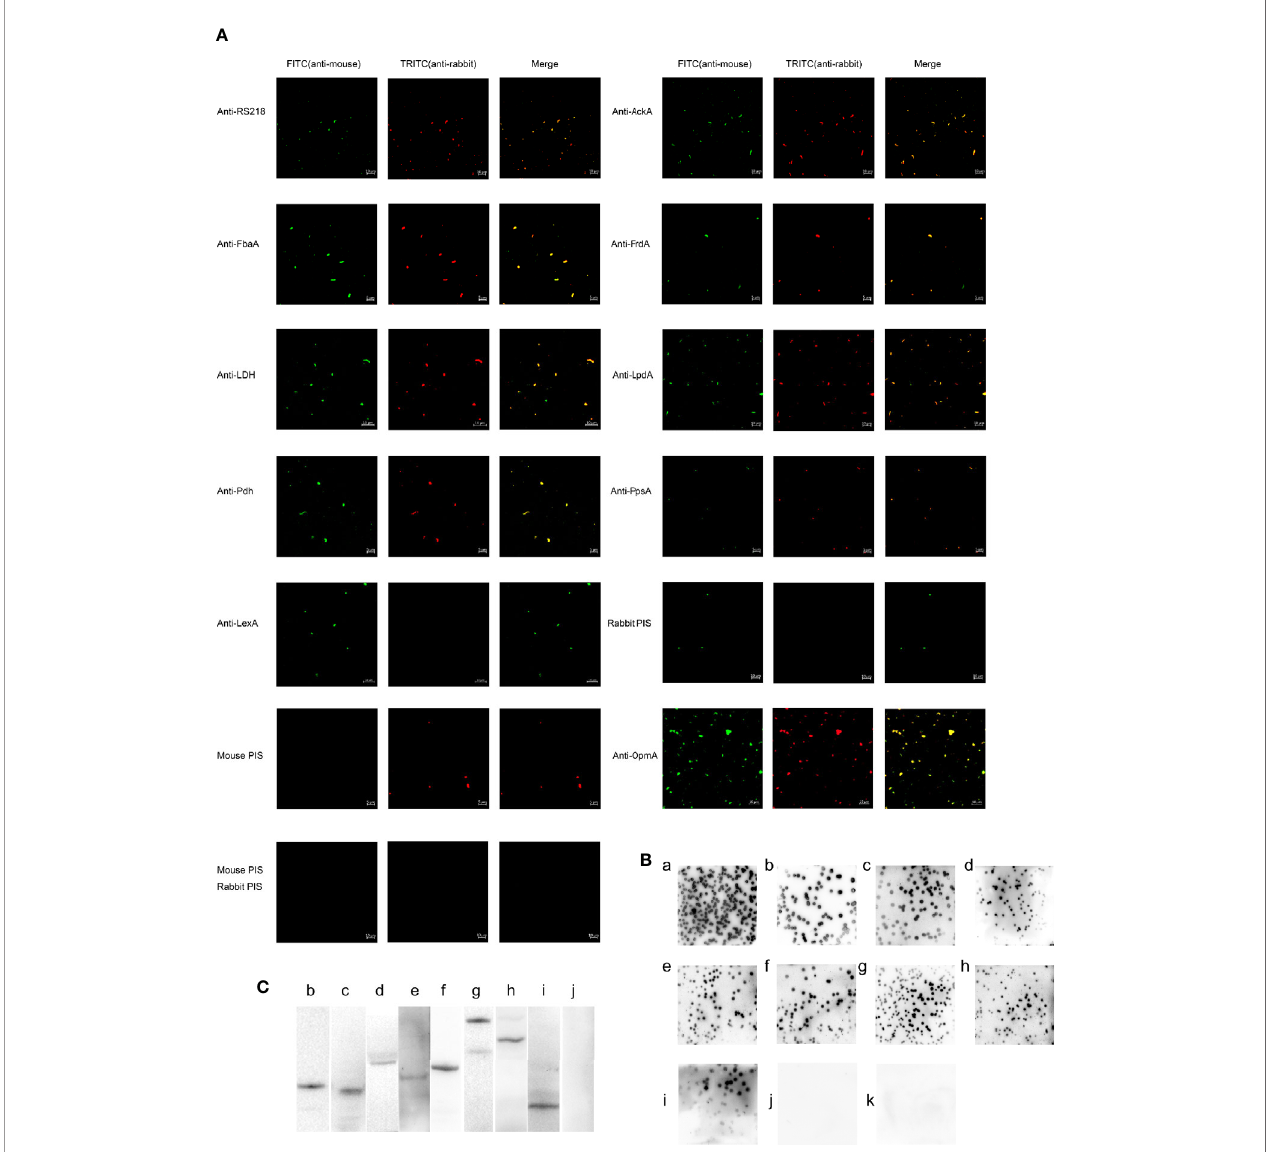
FIGURE 4 | The outer membrane localization of CMEs on ExPEC. (A) Immuno fl uorescence of ExPEC strain treated with the mixture of mouse anti-RS218 anti- serum and rabbit anti-RS218 anti-serum (positive control) or rabbit anti-OmpA antibody (out membrane protein control) or rabbit anti-CME antibody or rabbit anti- LexA antibody. The mixture of mouse anti-RS218 anti-serum and rabbit PIS, the mixture of rabbit anti-RS218 anti-serum and mouse PIS, and the mixture of mouse PIS and rabbit PIS was used as negative controls. Detection was conducted by incubating with FITC-conjugated anti-mouse IgG and TRITC-conjugated anti-rabbit IgG. (B) Immunoblotting reaction of ExPEC strain RS218 colonies. Colonies were covered with NC membrane followed by incubation with rabbit anti-RS218 anti- serum (a), anti-CMEs antibodies (b, anti-AckA; c, anti-FbaA; d, anti-FrdA; e, anti-LDH; f, anti-LpdA; g, anti-Pdh; and h, anti-PpsA), anti-OmpA antibody (i); anti-LexA antibody (j), and rabbit PIS (k). (C) The outer membrane proteins were extracted and detected by Western blotting (b, AckA; c, FbaA; d, FrdA; e, LDH; f, LpdA; g, Pdh; h, PpsA, i, OmpA; j,